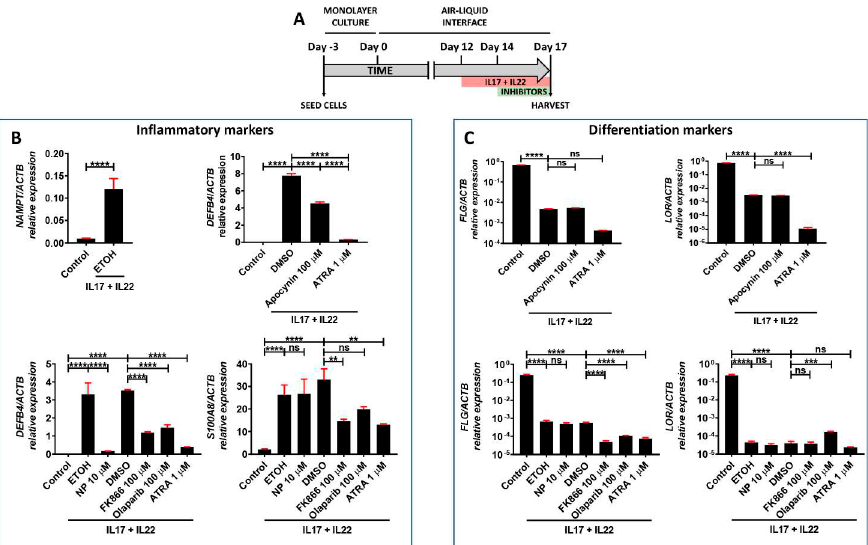
Fig 6. Reduction of pathology-associated gene expression in human organotypic 3D skin models of psoriasis. (A– C) Transcript levels of the indicated genes encoding inflammation (B) and differentiation (C) markers were determined in human organotypic 3D skin models pretreated with 30 ng/ml IL17A and IL22 in the presence of vehicles (ETOH and DMSO) or the indicated inhibitors. The mean ± SEM for each group is shown. The results are representative of 3 independent experiments. p -Values were calculated using 1-way ANOVA and Tukey multiple range test. ns, not significant. � p � 0.05, �� p � 0.01, ��� p � 0.001, ���� p � 0.0001. The data underlying this figure can be found in S1 Data. ANOVA, analysis of variance; ATRA, all-trans retinoic acid; NP, N-phenylmaleimide.